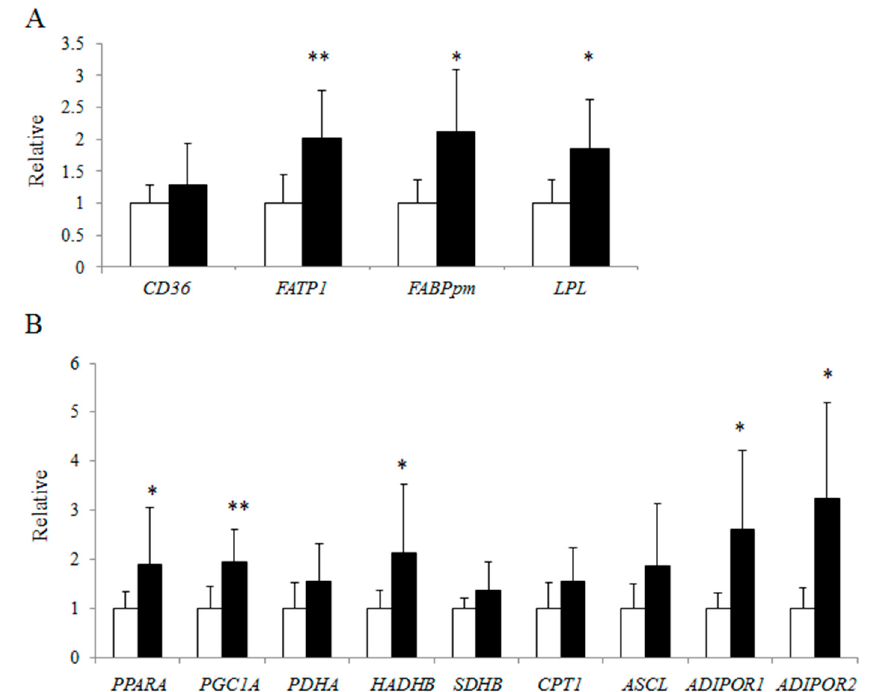
Figure 4. Gene expression analysis of skeletal muscle in the control and athlete groups using qRT-PCR. ( A ) Expression levels of fatty acid transporter in the control group (white bars) and the athlete group (black bars). Data are relative to the expression level in the control group, which was set to 1. ( B ) Expression levels of genes related to fatty acid β -oxidation in the control group (white bars) and the athlete group (black bars). Data are relative to the expression level in the control group, which was set to 1. * p < 0.05, ** p < 0.01. Values were obtained by normalization to a housekeeping gene ( ACTB ). Data are presented as means ± SD. CD36 : CD36, FATP1 :